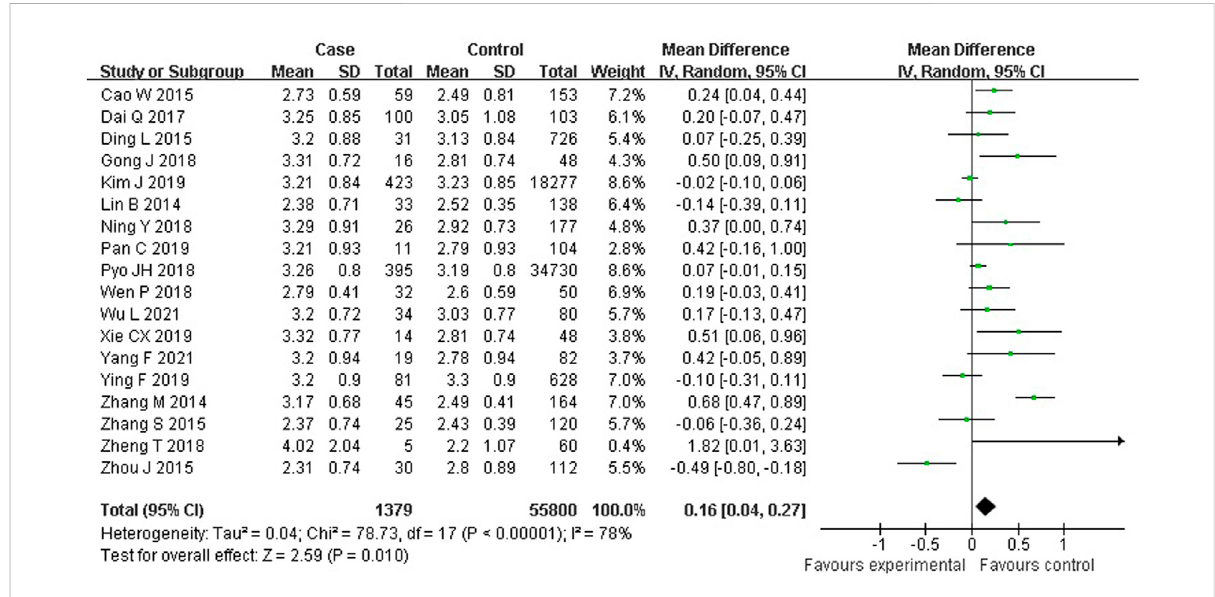
FIGURE 3 Forest plot of meta-analysis for association of serum LDL-C and colorectal serrated